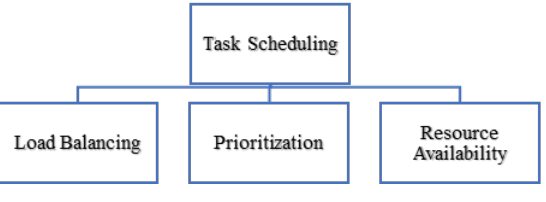
Figure 1. Critical task management.